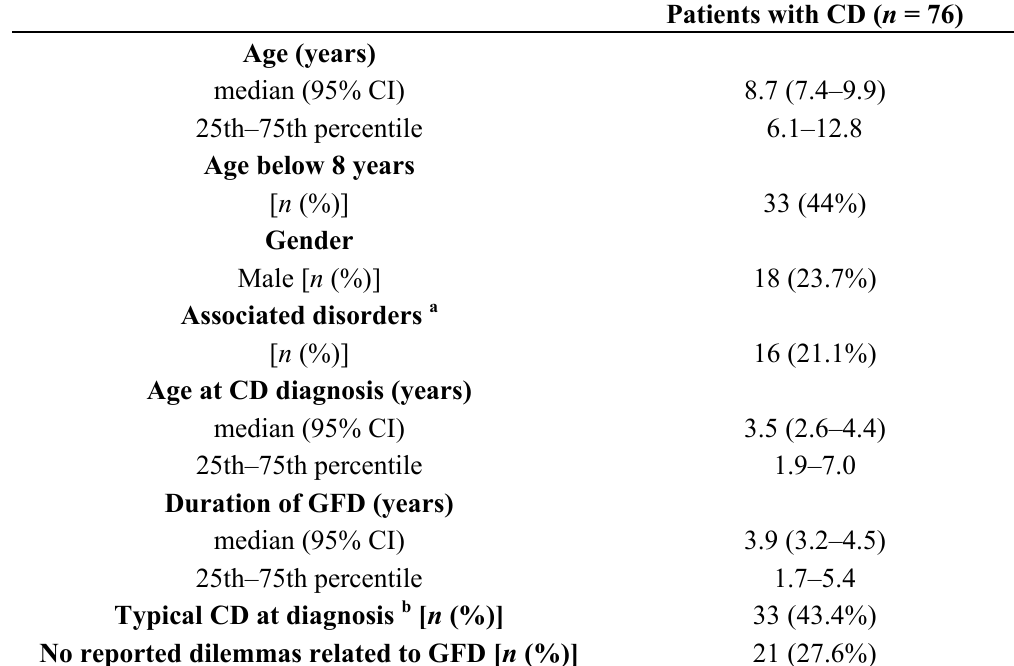
Table 1. Main characteristics of study